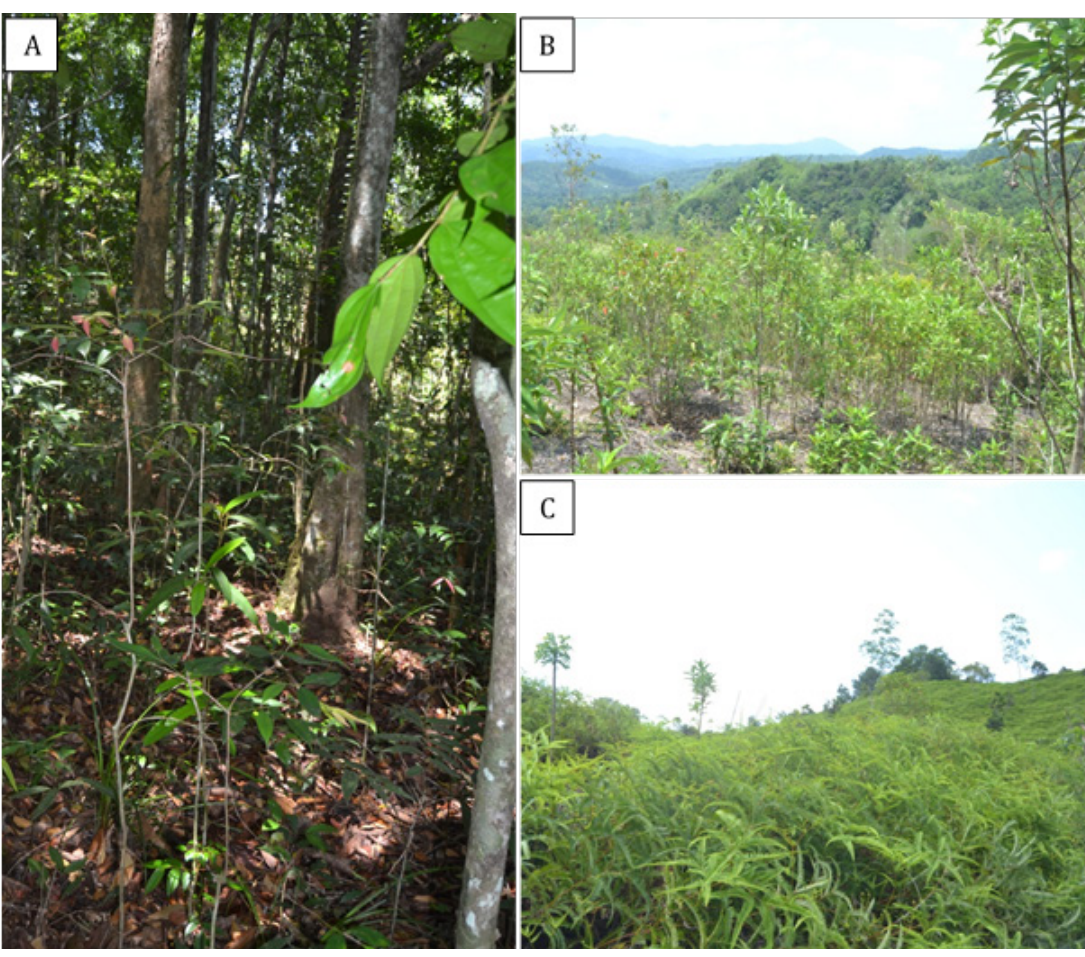
Figure 1: The three land use types used in the study are; A - lowland rainforest (LR), B - shrub-dominated site (SD) and C - Dicranopteris -dominated fernland (DD) in Kanneliya Forest Reserve, Sri Lanka. AMF spore abundance and